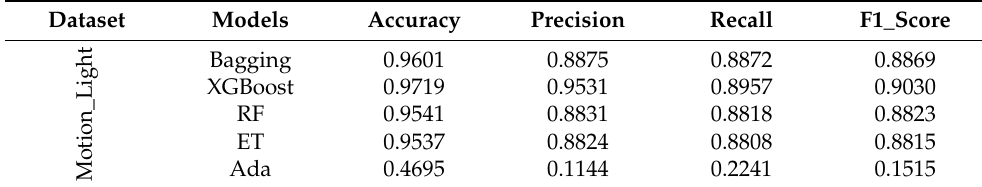
Table 8. The classification report for the Motion_Light dataset.